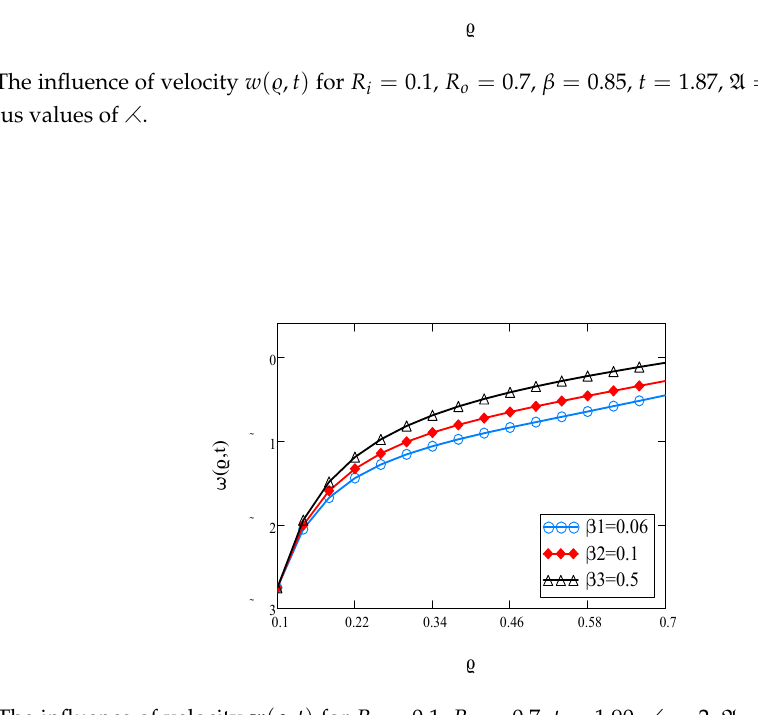
Figure 4. The influence of velocity w ( (cid:36) , t ) for R i = 0.1, R o = 0.7, t = 1.90, (cid:105) = 2, A = 5, ν = 0.45 and Ω = 3 with various values of β .